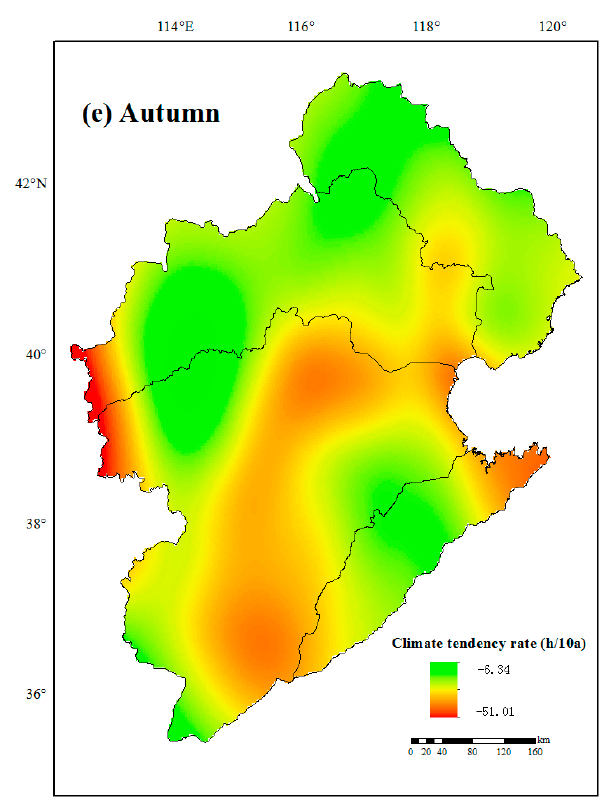
Figure 8. Spatial distribution of climate tendency rate for sunshine duration during 1966–2015.